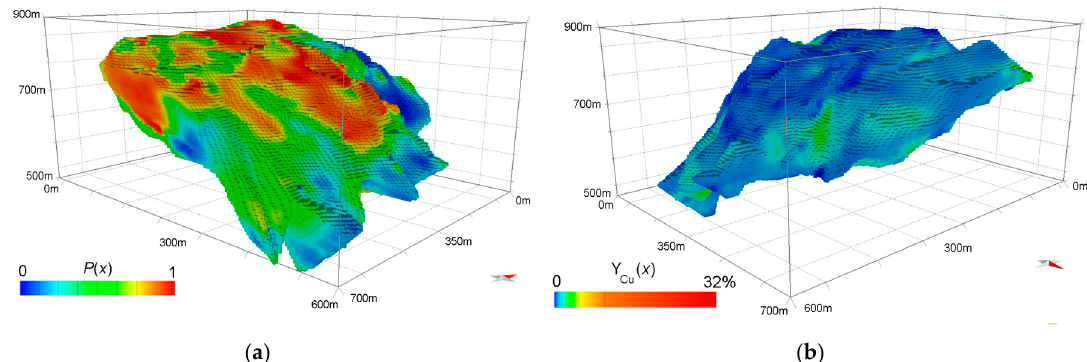
Figure 6. 3D view of ( a ) average values of proportion variable P ( x ); ( b ) average relative copper grades Y Cu ( x ) (%).